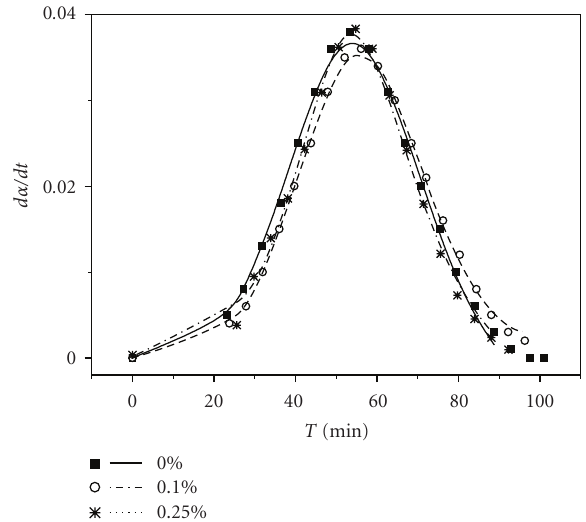
Figure 9: Comparison of experimental data (dotted curves) with the kinetic model data (lines) for the isothermal curing of neat epoxy resin (0%) and nanocomposites reinforced with 0.1 and 0.25wt% CNTs.